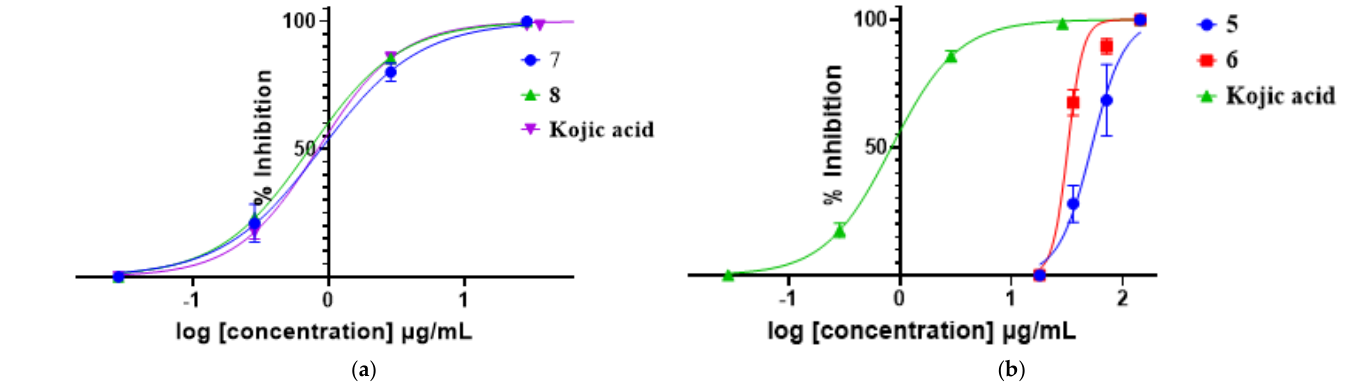
Figure 4. Inhibitory effects on tyrosinase activity of compounds 7 and 8 ( a ), 5 and 6 ( b ), and the positive control, kojic acid. Table 3. Tyrosinase inhibitory activity of the isolated compounds.